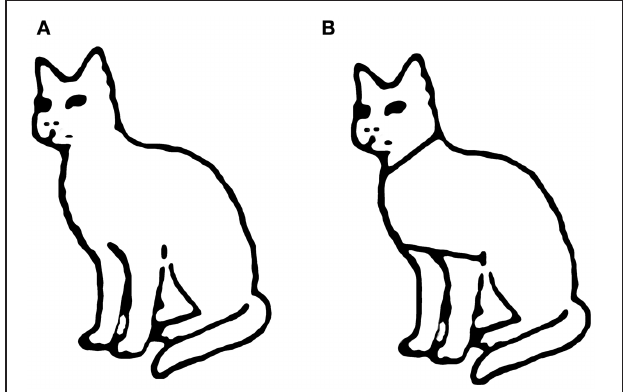
FIGURE 2 | Example of stimuli from Riddoch and Humphreys (2004) showing (A) line drawing of animate object and (B) artificial segmentation of that line drawing.